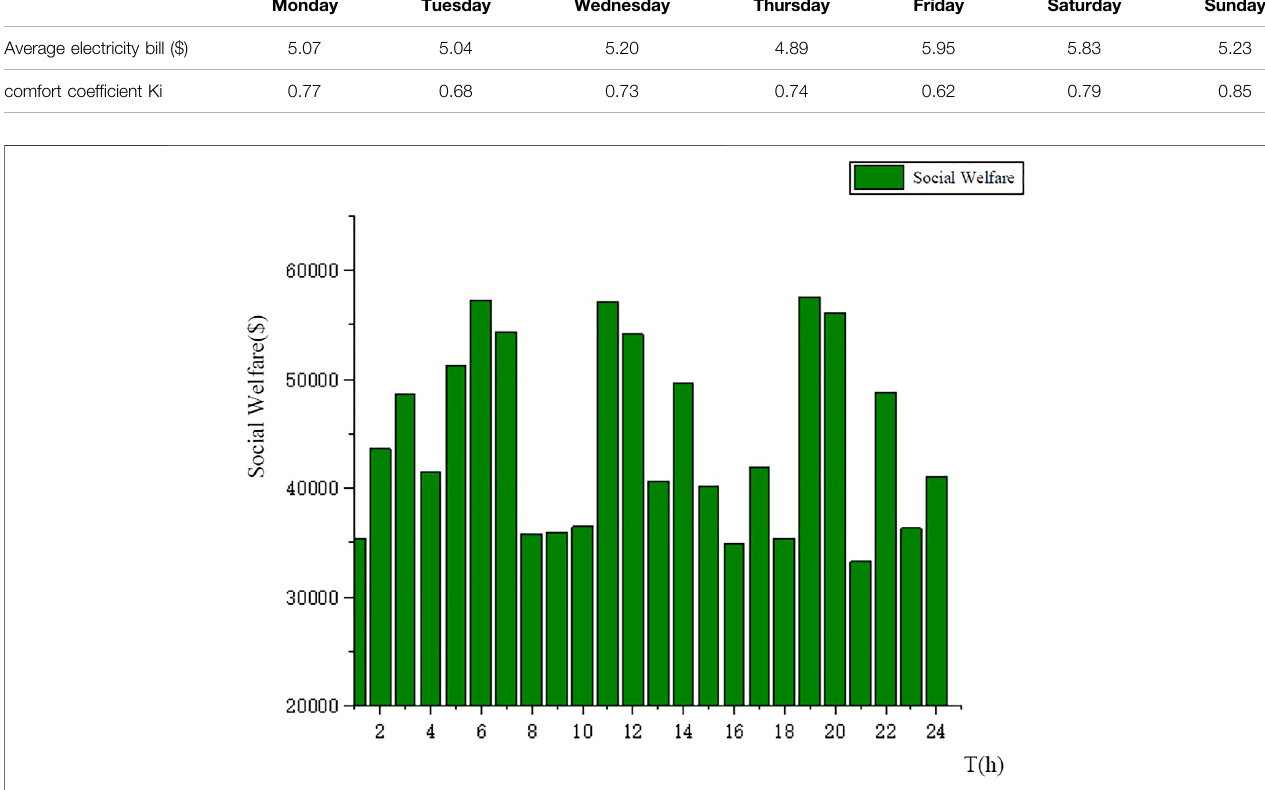
Frontiers in Energy Research |